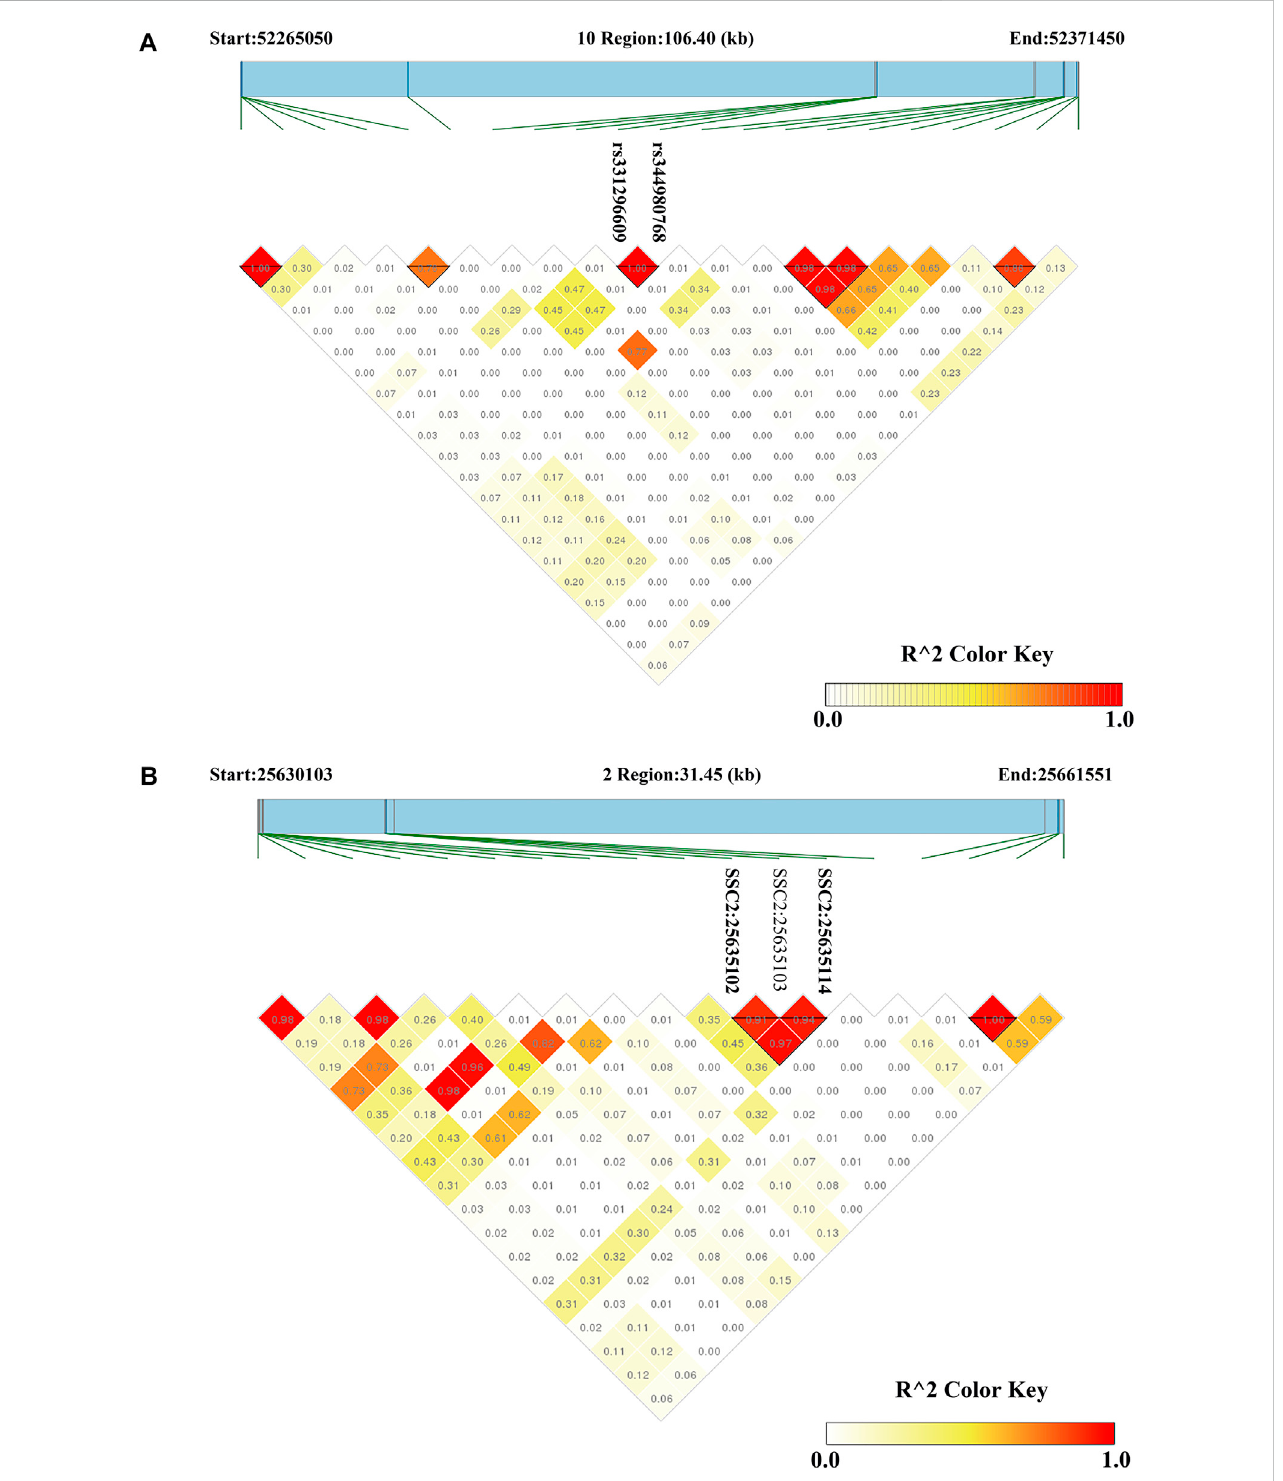
FIGURE 3 Haploview plots of linkage disequilibrium (r2) between SNPs on pig chromosome. (A) A region on SSC10 (106.40 kb) contained a haploview block with two signi fi cant SNPs related to CL (B) A region on SSC2 (31.45 kb) contained ahaploview block with two signi fi cant SNPs related to DL. Values inthe diamond are r 2 values between SNPs. The darker the color, the stronger the correlation between two